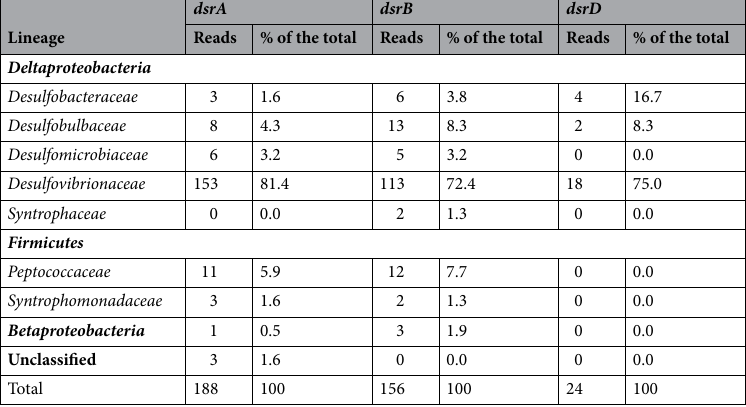
Table 2. Taxonomic assignment of dsr